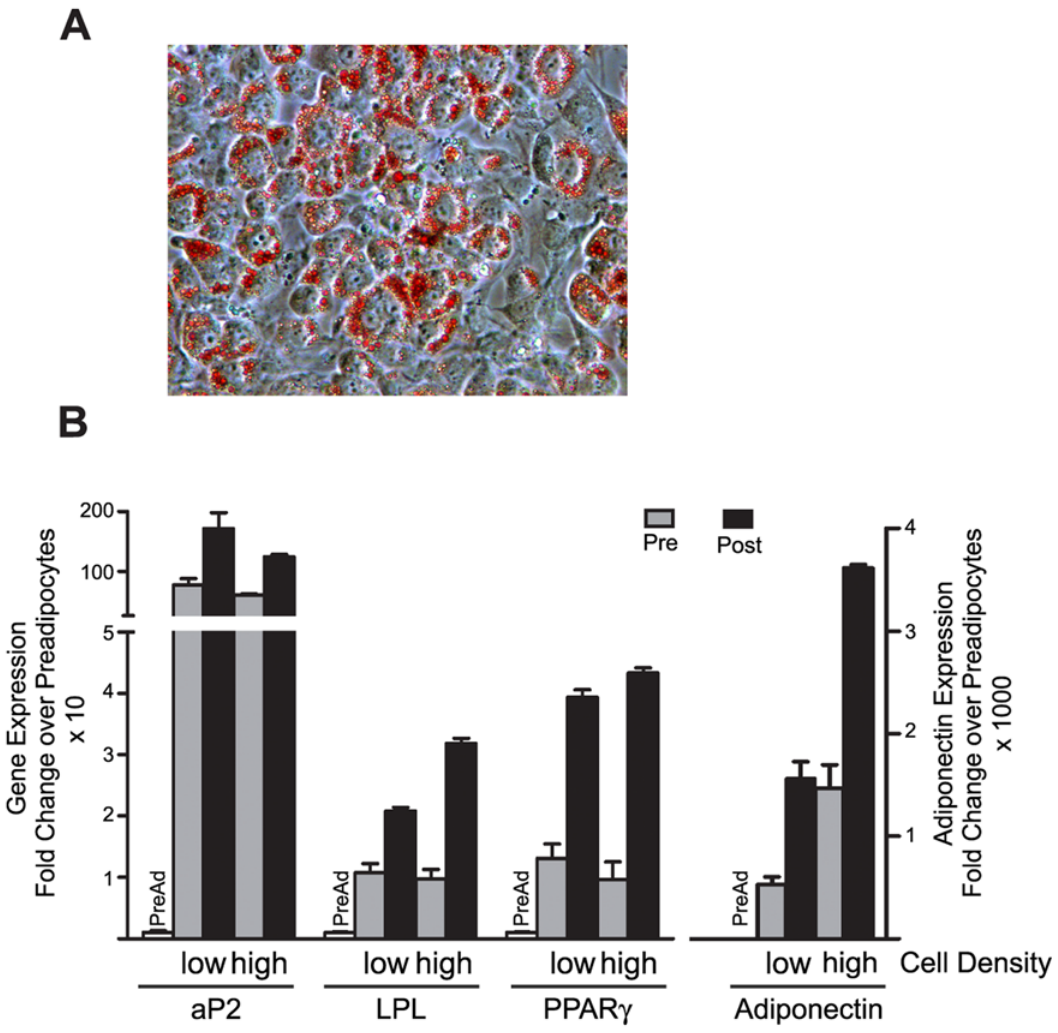
Figure 1. Adipocytes continue to differentiate after harvesting and replating post-induction. The 3T3-L1 preadipocytes were induced to undergo adipogenesis and harvested at day 3–4 post induction when lipid droplets were clearly visible. (A) Oil Red O staining of neutral lipids forty- eight hours after harvesting and replating. (B) The gene expression of adipocyte marker genes aP2, LPL, PPAR c , and adiponectin was measured via real-time PCR upon harvesting (Pre) and forty eight hours after (Post) the adipocytes were replated at 5.4 6 10 4 cells/cm 2 (low) or 1.16 6 10 5 cells/cm 2 (high) and compared to the expression of each gene in preadipocytes prior to induction (preAd). Expression of each gene was assayed in triplicate, normalized to cyclophilin B gene expression, and reported as the mean and standard deviation. The results are representative of experiments carried out twice independently.